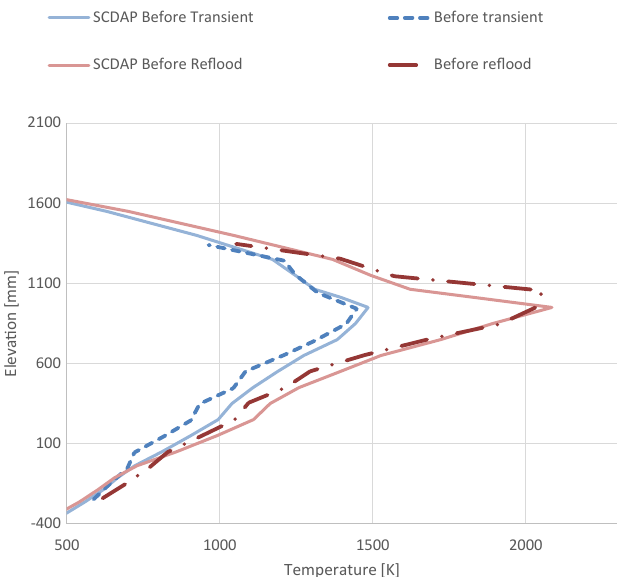
Fig. 6. Axial bundle temperature pro fi les before transient and before re fl